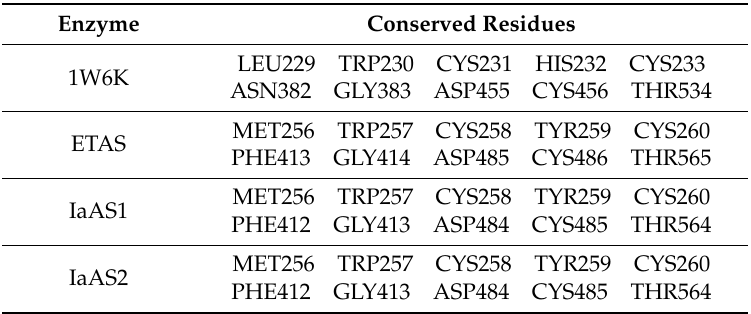
Table 1. Conserved residues in template, ETAS, IaAS1 and IaAS2